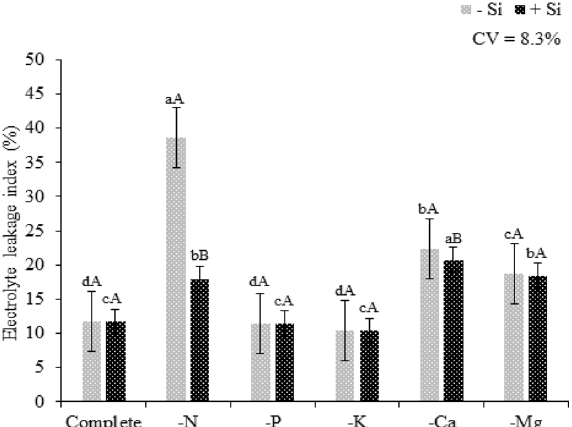
Figure 6. Electrolyte leakage index of quinoa plants in a Hoagland solution (Hoagland and Arnon 23 ) under omission of macronutrients in the absence (− Si) and presence of silicon (+ Si). Equal lowercase letters demonstrate a similarity between the omitted and complete treatments by Tukey’s test at 5% probability. Equal uppercase letters show a similarity between treatments (− Si and + Si) by Tukey’s test at 5% probability. Software used to create this Figure was Microsoft Excel (v1804, https:// www. micro soft.